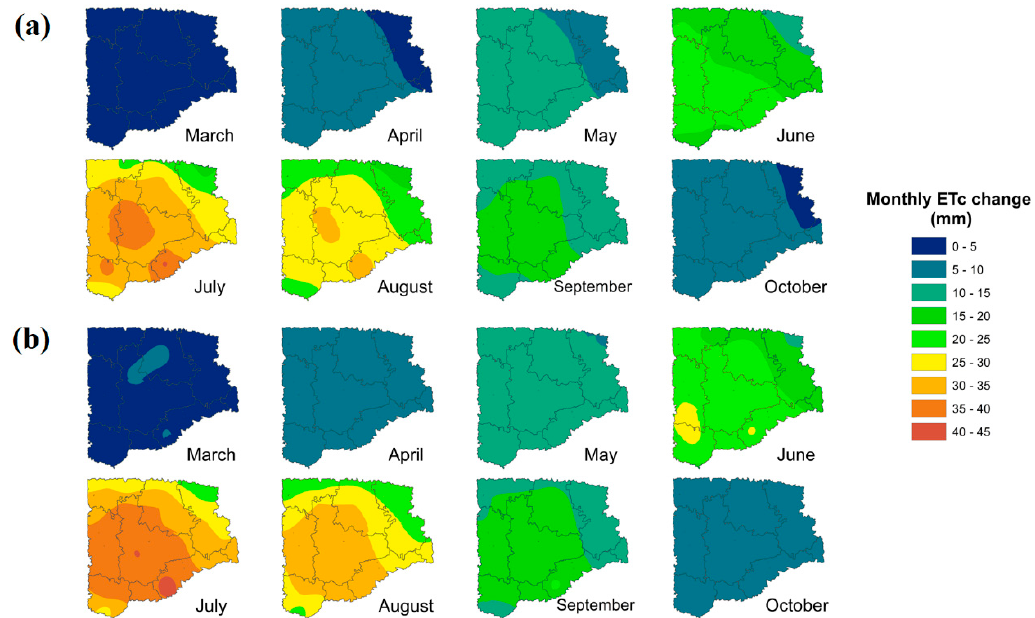
Figure 5. Spatial distribution of monthly crop evapotranspiration (ETc) changes in the area of study for ( a ) 2050 and ( b ) 2070 scenarios, compared to the baseline scenario.